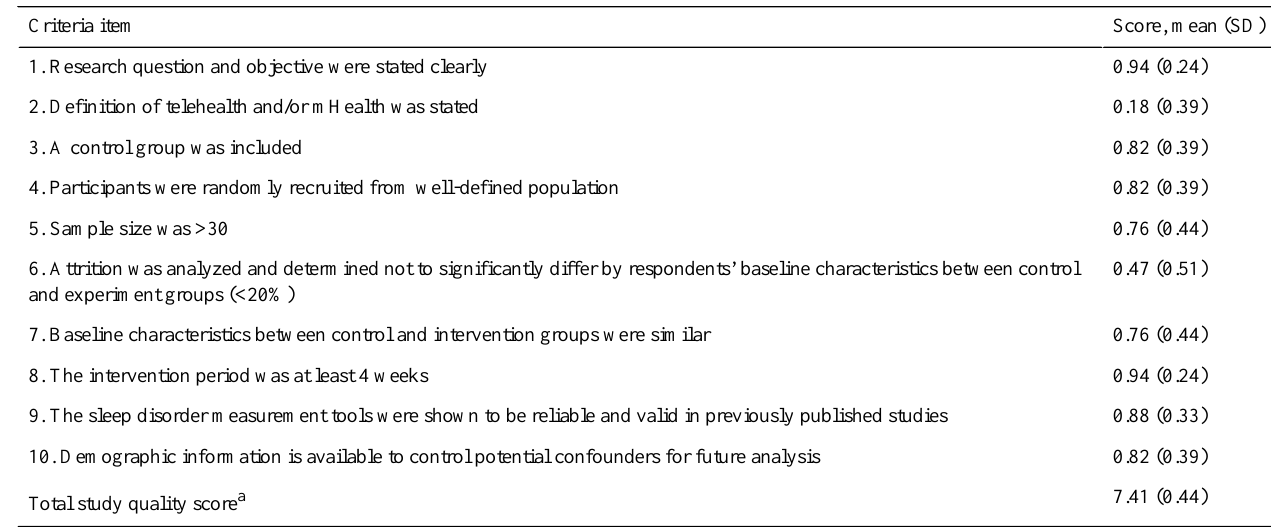
Table 4. Quality assessment of studies to determine the impact of sleep intervention with mobile technology on sleep disorders.